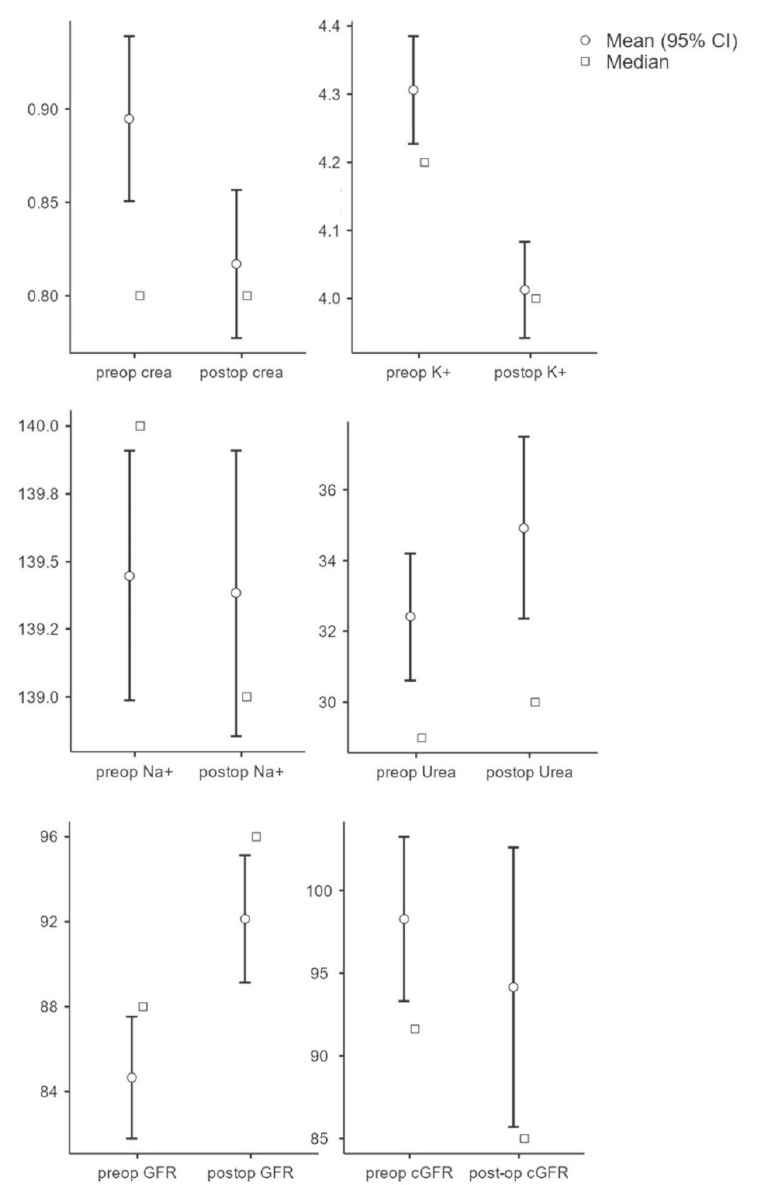
Figure 1. Overview of parameters (creatinine, potassium, sodium, urea, GFR, and cGRF) in pre- and postoperative comparison.